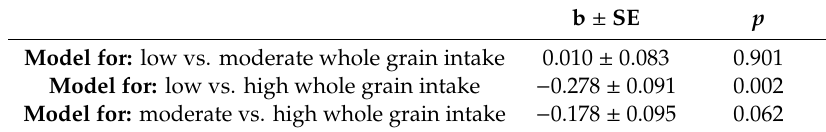
Table 2. Results from linear regression models that evaluated the association of whole grain intake on successful ageing (outcome) among ATTICA (n = 1128) and MEDIS (n = 2221) study participants. b ± SE p Model for: low vs. moderate whole grain intake 0.010 ± 0.083 0.901 Model for: low vs. high whole grain intake − 0.278 ± 0.091 0.002 Model for: moderate vs. high whole grain intake − 0.178 ± 0.095 0.062